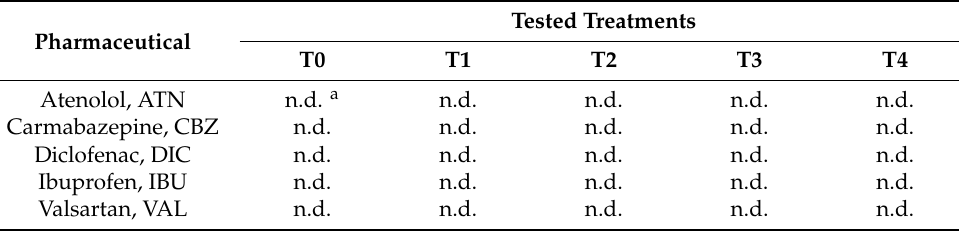
Table 4. Concentrations of the target PhCs in the plant samples obtained in the different tested